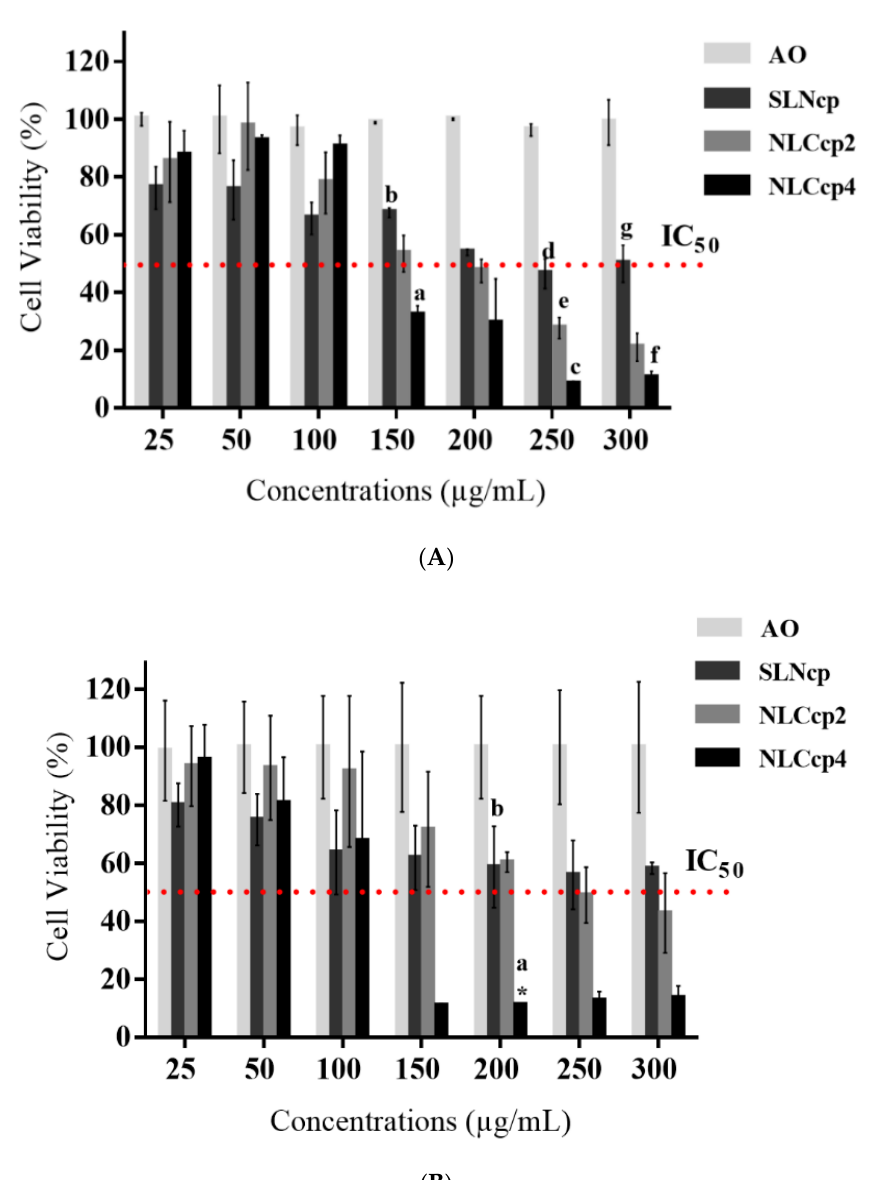
(NLCcp4) had expressive cytotoxicity in samples with a concentration of ≥ 150 µ g/mL for keratinocytes, unlike samples of NLCcp2 that only displayed a cytotoxic effect at at concentration of ≥250 μg/mL. concentration of ≥ 250 µ g/mL.